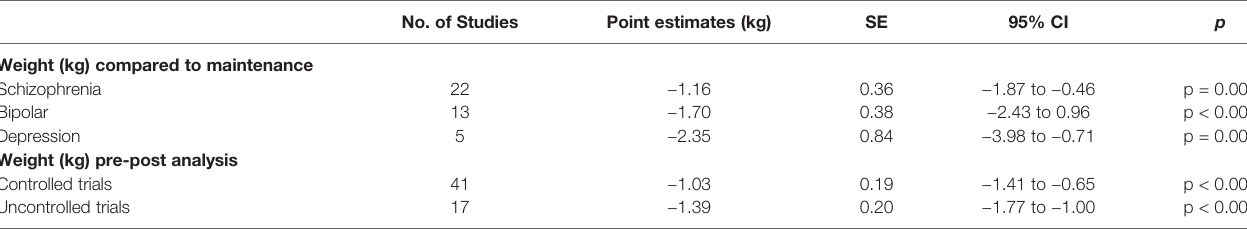
TABLE 4 | Results for subgroup analyses and meta-regressions, including weight in kilogram (kg) grouped by diagnoses,and type of study design, standard error (SE), 95% con fi dence intervals (95% CI). No. of Studies Point estimates